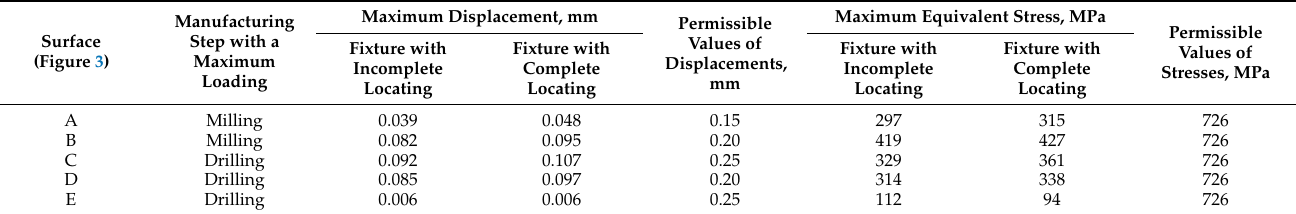
Table 3. Numerical simulation